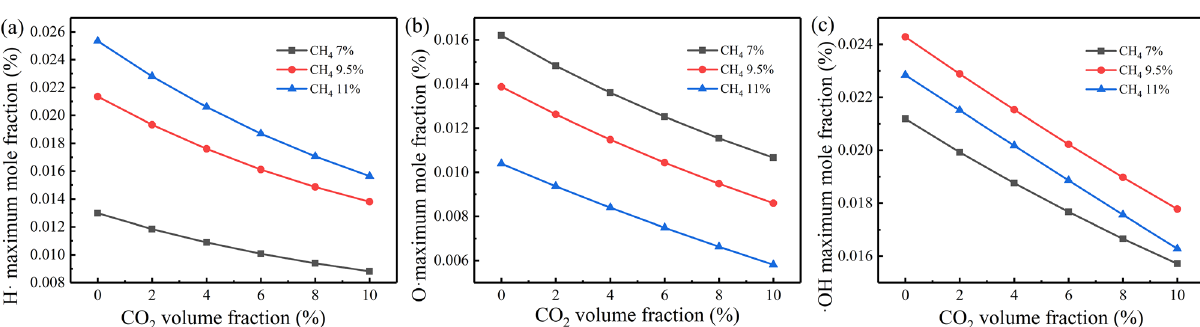
Figure 4. Variation of maximum mole fraction of free radicals with CO 2 volume fraction under different methane volume fractions: ( a ) free radical H, ( b ) free radical O, and ( c ) free radical